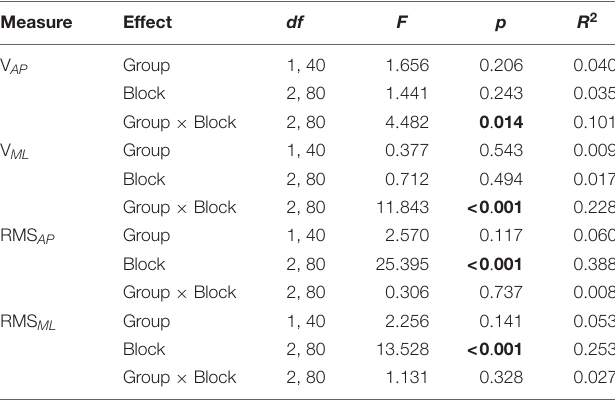
TABLE 3 | Experimental effects induced by exposure to virtual height: summary of linear mixed effect models for postural measures.